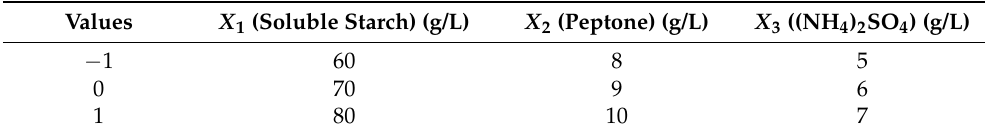
Table 5. Design of factors and